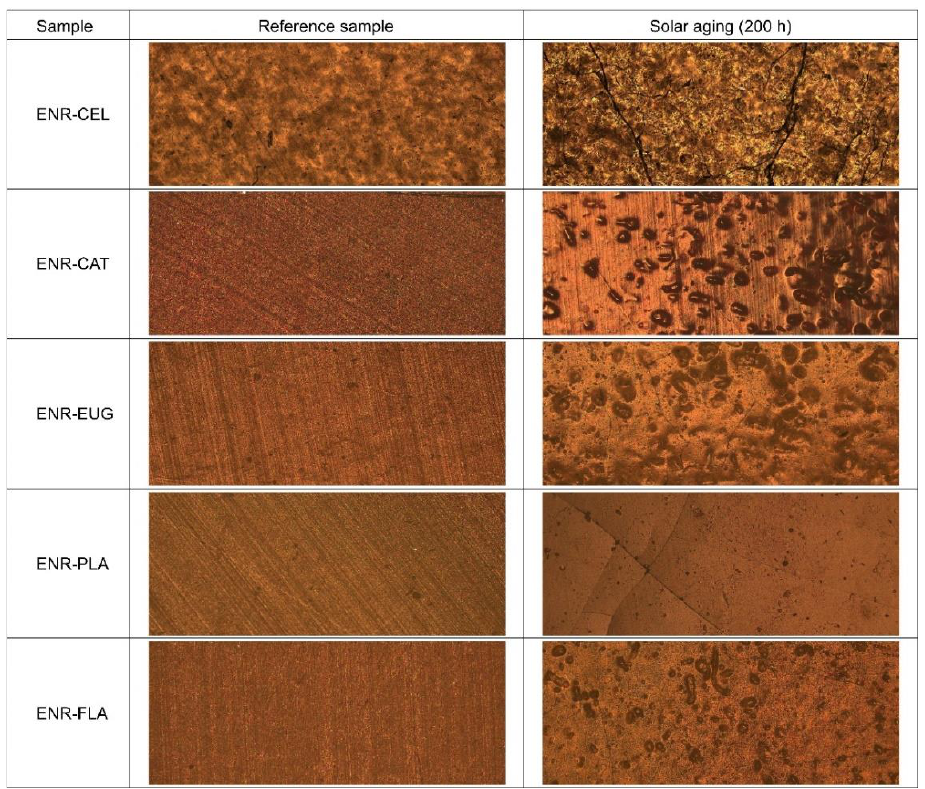
Figure 10. Effect of solar aging on the surface properties of ENR-based composites examined by optical microscopy at 50x magnification.